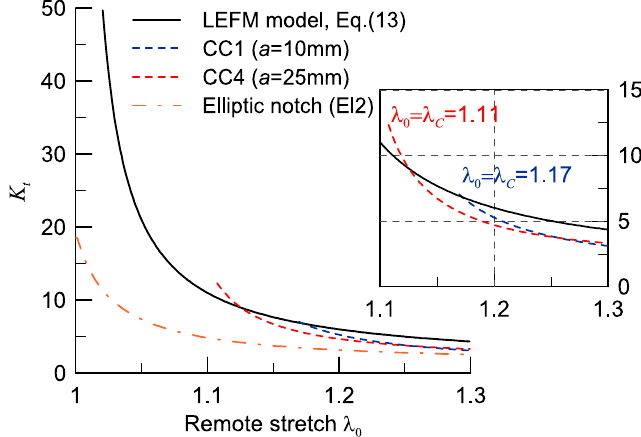
Figure 11. Stress concentration factor as a function of the remote applied stretch. Prediction of the ‘pure’ LEFM model (continuous line) and results obtained from the ‘modified’ model, in the center-cracked specimens CC1 and CC4. The dash-dot line refers to the elliptically-notched plate El2. The enlarged view shows the region 1.1 < λ < 1.3.